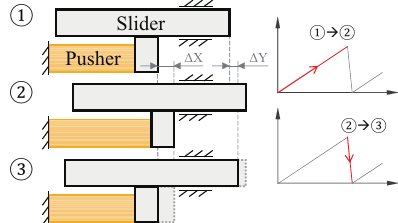
Figure 1. Driving principle of a linear inertia-drive motor. The transition from 1 (cid:13) to 2 (cid:13) represents the stick phase, while 2 (cid:13) to 3 (cid:13) represents the slip phase. The curve graph on the right represents the displacement of the pusher part vs.